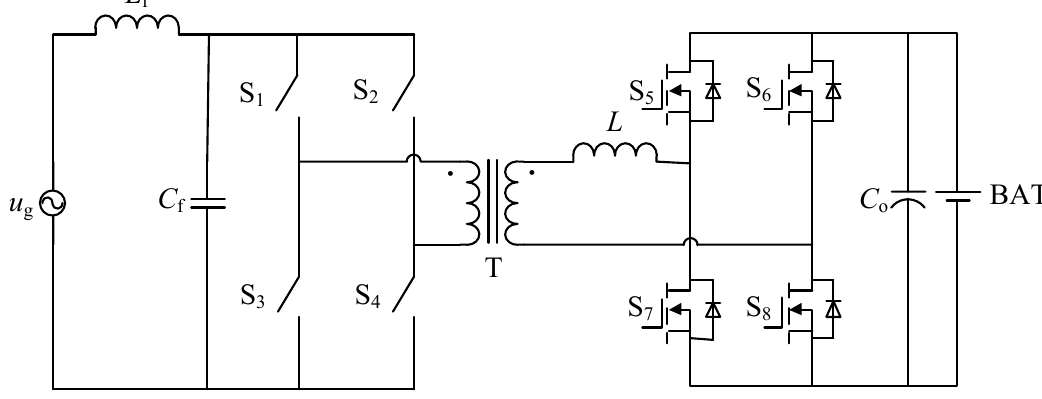
Figure 8. A bidirectional single-stage topology based on AC-DC dual-active-bridge